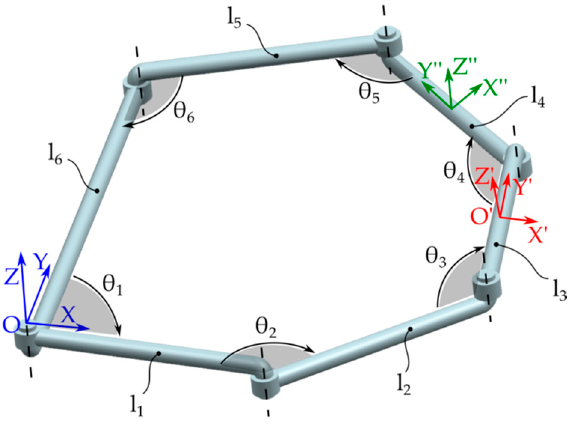
Figure 2. The 6R closed loop mechanism.